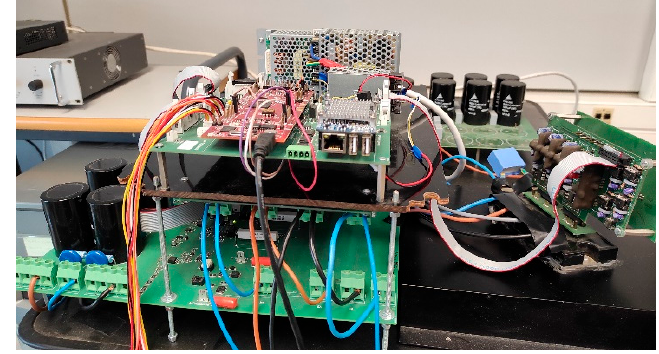
Figure 16. Experimental setup.